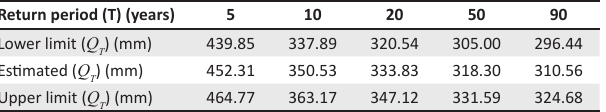
TABLE 7: Q-T results: X3B agricultural drought events of maize in December to February growing period. Return period (T) (years)